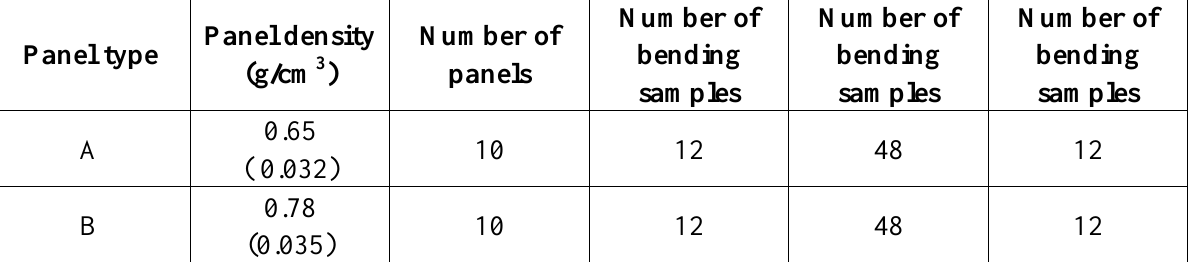
Table 1. Sampling design (values in parenthesis are standard